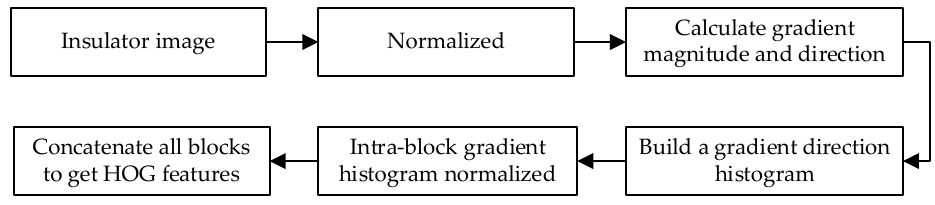
Figure 4. Flow chart of seed region segmentation based on morphological improvement.